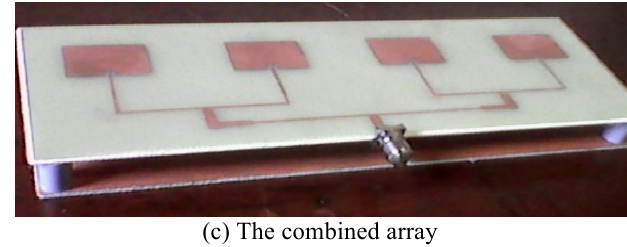
Figure 8: Photographs of the patch array prototype and measurement setup, (a) top layer, (b) ground plane with slots, (c) the combined overall array.